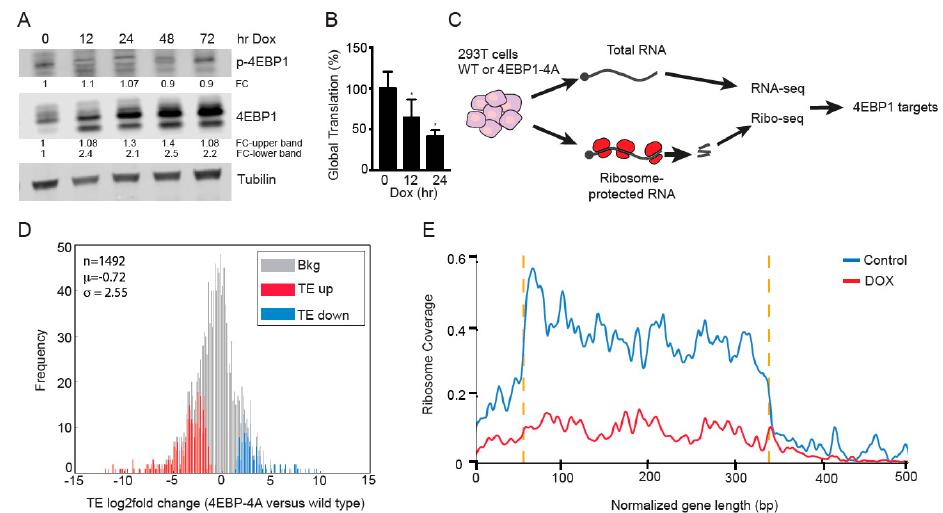
Figure 4. Ribosome footprinting identifies translational targets of 4EBP1. ( A ) Immunoblot showing the overexpression of 4EBP1-4A mutant form in a doxycycline-dependent manner in 293T cells at the indicated time points. Phosphorylation of 4EBP1 at Ser 65 remained reduced in the doxycycline- treated cells compared to the untreated control cells that had basal levels of phosphorylated 4EBP1 (Ser 65). Quantification of respective proteins is indicated as fold change (FC) normalized to b-actin and untreated 293T cells. ( B ) Global mRNA translation was reduced following doxycycline-induced overexpression of 4EBP1-4A mutant protein in 293T cells as measured by AHA incorporation. ( C ) Schematic showing the experimental design for RNA seq and ribosome footprinting in 293T wild- type or 4EBP1-4A-mutant-expressing cells. A comparison of ribosome-protected sequences and to- tal mRNA isolates the translational efficiency for each mRNA (TE). ( D ) Frequency distribution of the change in translation efficiency (TE) in control (WT 4EBP1) and doxycycline-treated (4EBP1-4A mutant) 293T cells. Using the statistical cut-offs of q < 0.05, we identified mRNAs with decreased (TE-down, red) and increased (TE-up, blue) and unchanged translation (background, gray) in three biological replicates. ( E ) Ribosome coverage was reduced throughout the mRNA length in the TE- down mRNAs in doxycycline-treated cells compared to the control cells.